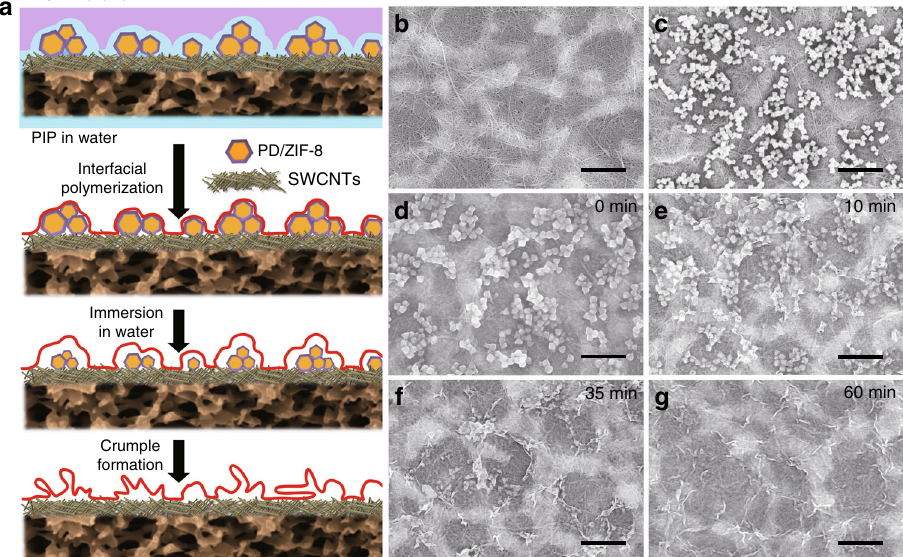
Fig. 1 Evolution process of PA NF membrane with crumpled structures. a A schematic illustration showing the preparation process of nanoparticles- induced crumpled PA NF membrane. Top-view SEM images of b pristine SWCNTs/PES composite membrane, c PD/ZIF-8 nanoparticles loaded SWCNTs/ PES composite membrane. d – g Morphology change of the membrane immersed into water in different time after interfacial polymerization reaction on PD/ ZIF-8 nanoparticles loaded SWCNTs/PES composite membrane (The scale bar of images is 1 μ m). The PD/ZIF-8 nanoparticles loading mass is 4.3 μ g cm − 2 . (TMC trimesoyl chloride, PIP piperazine, SWCNTs single-wall carbon nanotubes, PD shows a uniform network structure with the effective pore size loaded SWCNTs/PES composite membrane, the membrane was ranging from 10 to 20 nm (see Supplementary Figure 2c). The immersed into water to release the ZIF-8 nanoparticles. surface chemical components of the SWCNTs fi lm as analyzed by Figure 1d – g are SEM images of the membrane with different XPS con fi rms the existence of PD on carbon nanotubes (see immersion time. Before immersed into water, the PD/ZIF-8 Supplementary Figure 2d and 2e). This PD layer renders the nanoparticles and SWCNTs fi lm could be clearly observed under SWCNTs fi lm hydrophilic as con fi rmed by a water contact angle the PA layer, indicating the top PA layer was rather thin and (CA) of 22°. The evolution of the crumpled active layer of the transparent (Fig. 1d). The morphology of the PD/ZIF-8 nano- particle was similar before and after interfacial polymerization reaction, which suggests that the PD/ZIF-8 nanoparticles were brane fabrication process. The SEM image of the pristine stable during the polymerization reaction (see Supplementary SWCNTs fi lm, covering the PES MF membrane before interfacial Figure 7). Immersion the membrane into water after poly- polymerization, suggests a smooth and transparent network merization promotes the gradual dissolution of the PD/ZIF-8 nanoparticles (Fig. 1e – g). As the dissolution process continued, the crumpled surface morphology started to emerge and became growingly prominent until the PD/ZIF-8 nanoparticles dissolved completely (Fig. 1g). The dissolution of ZIF-8 nanoparticles is ascribed to their instability in water at a low mass ratio of ZIF-8 to water 31,32 . A series of experiments were done to con fi rm such a dissolution water, water containing 1 M Hmim and alkaline solution (pH: